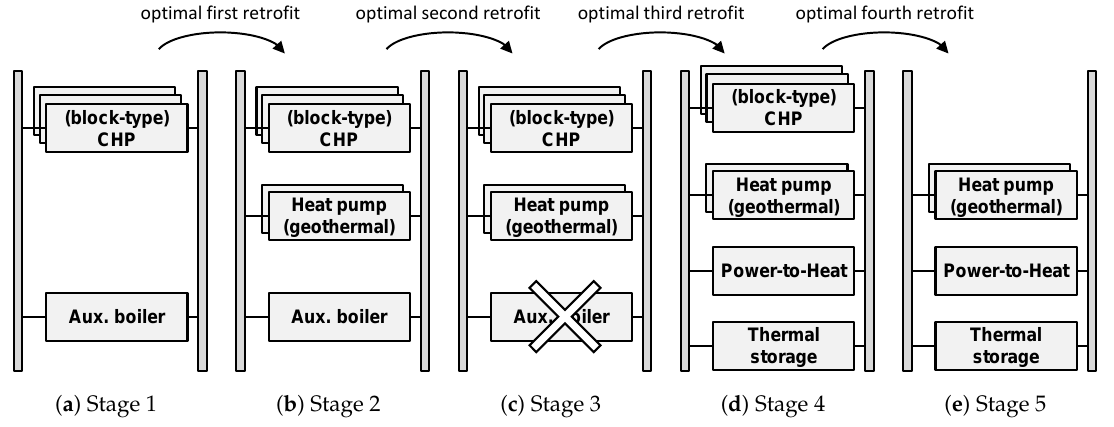
Figure 7. Assumed evolution of a configuration over years and